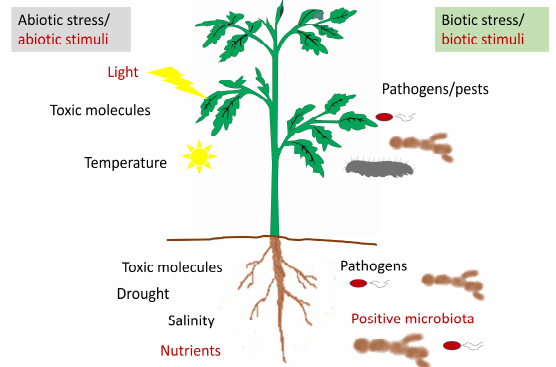
Figure 2. Representative diagram of the stresses and stimuli perceived by the plant that could modify the apoplastic content.